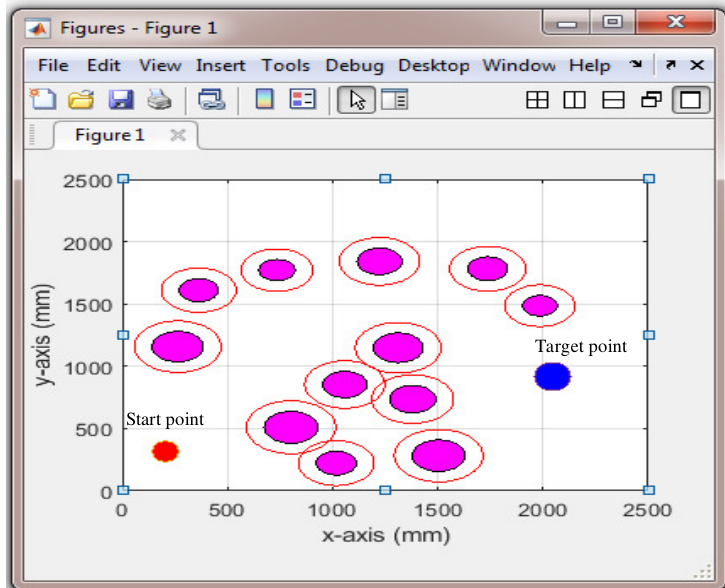
Fig. 9. The Environment of Case